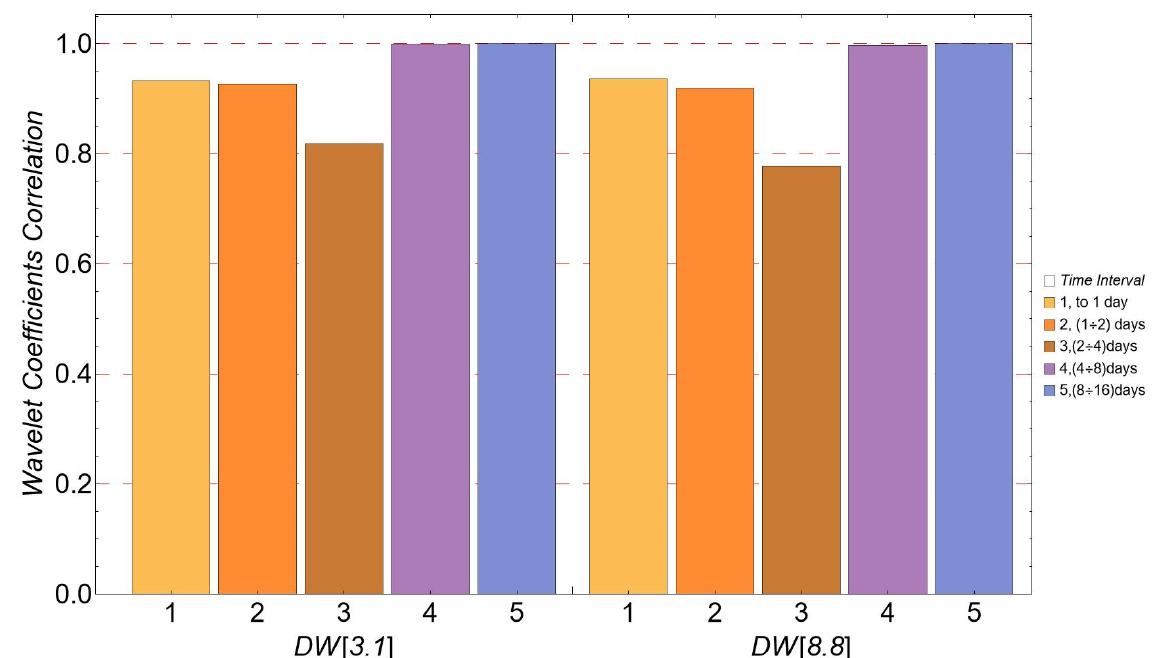
Figure 9. Variance chart plots for the first four components after the DWT-based decomposition: the test part of the original time series in the range from 301 to 355time steps (black); the forecast based on DW [3.1] transformation (blue); the forecast based on DW [8.8] transformation (red). Source: authors’ calculations.